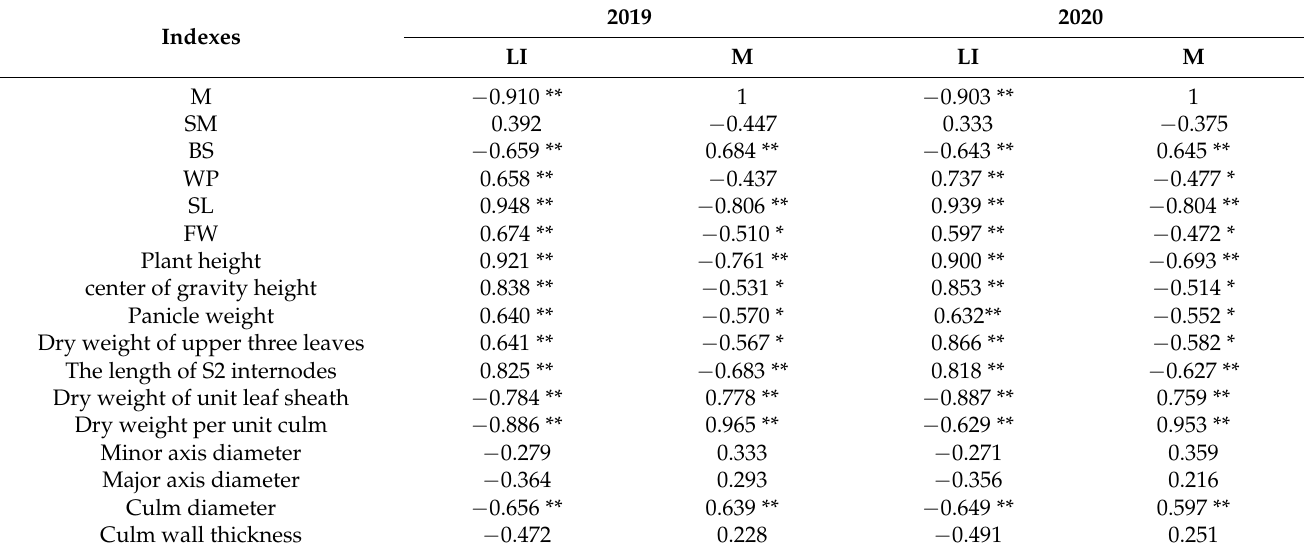
Table 9. LI and its related parameters of the S2 basal internode in 2019 and 2020 (n = 18).